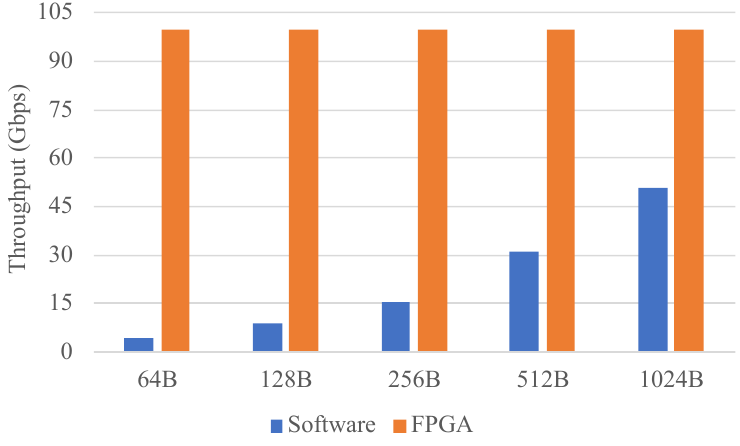
Figure 13. Packet filtering. The throughput of the software and the